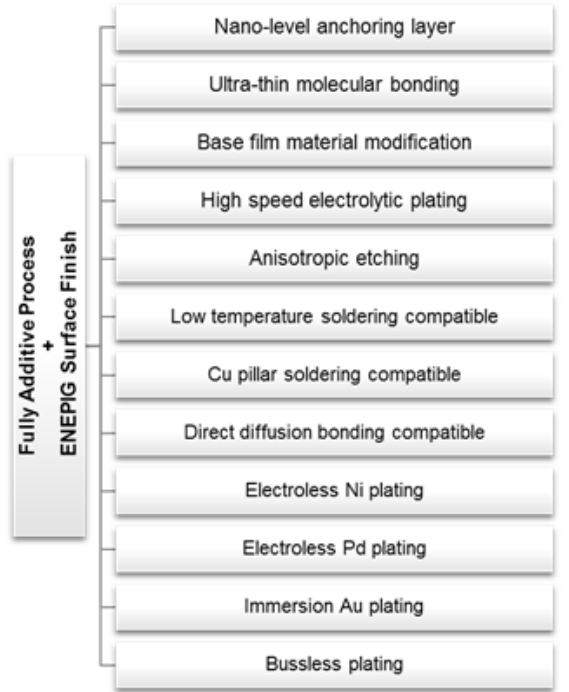
Figure 5. Features of the proposed state-of-the-art technology